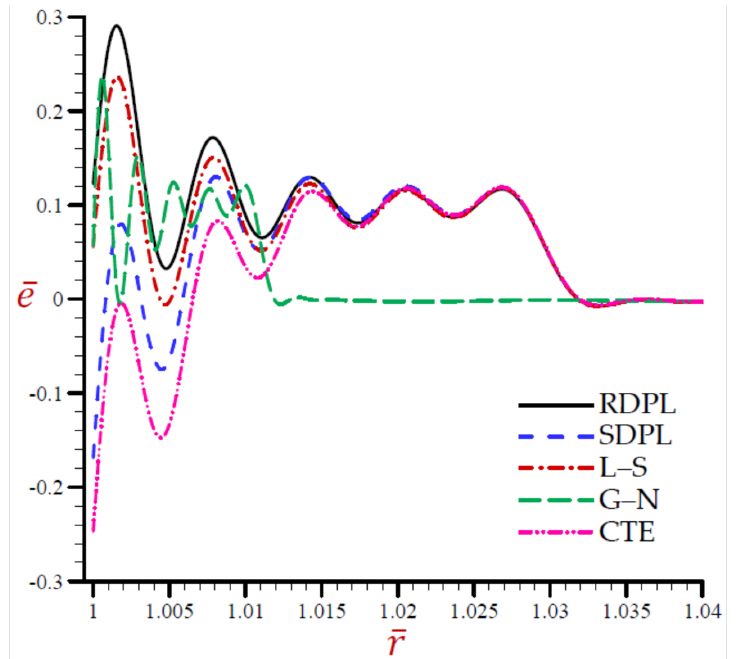
Figure 2. The dilatation e across the radial direction of the cylindrical cavity conferring to all theories.